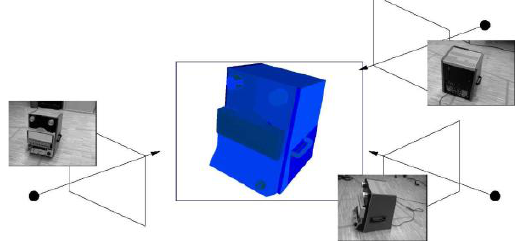
Figure 9. Keyframes generated from three different camera poses.